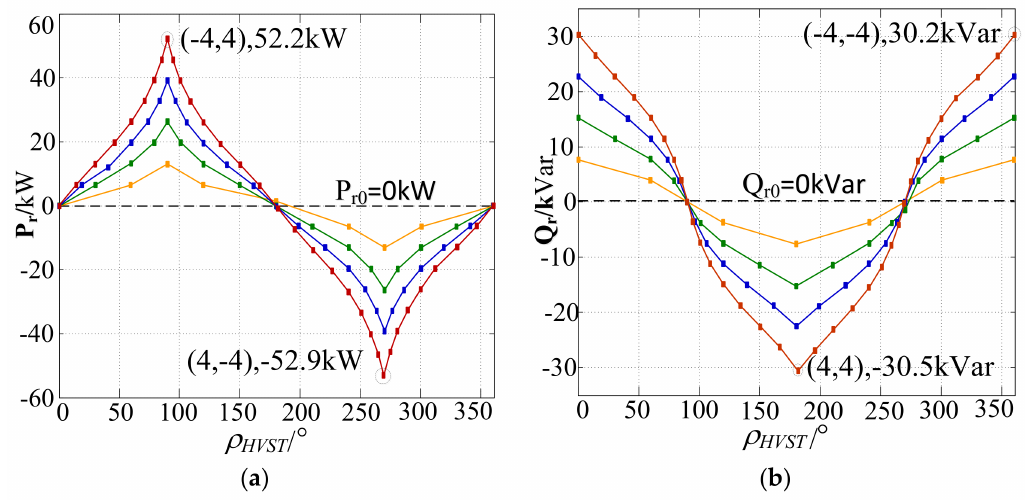
Figure 17. The P r and Q r experimental results at a varying series voltage ( U HVST ) and phase angle ( ρ HVST ) for the HVST. ( a ) The active power flow P r ; ( b ) The reactive power flow Q r